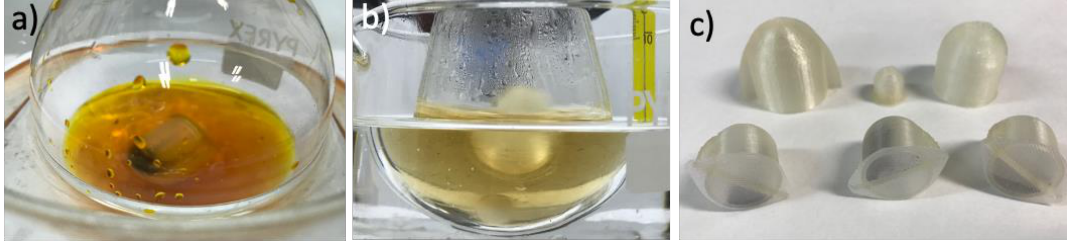
Figure 5. ( a ) Heck reaction mixture using Capsule@IRA-120-Pd(0). ( b ) Capsule@ IRA-120-Cu(0) during CuAAC. ( c ) Different shapes and sizes of 3D-printed capsule prototypes.